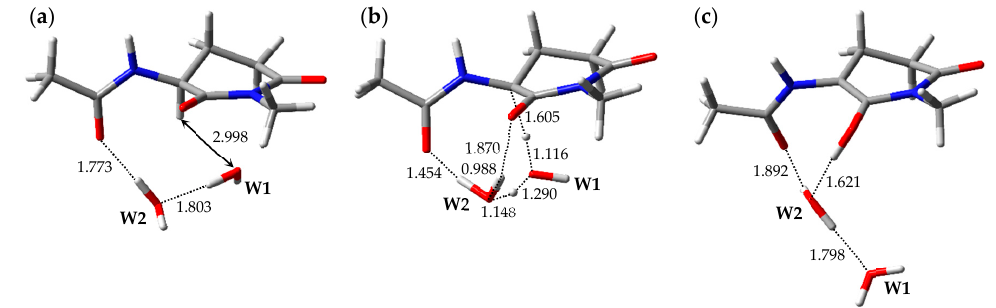
Figure 3. Optimized geometries of the enolization system in Pathway 2: ( a ) 2-RC ( φ = − 101°, ψ = − 158°, χ 1 = − 180°, χ 2 = − 53°); ( b ) 2-TS ( φ = − 87°, ψ = − 152°, χ 1 = 176°, χ 2 = − 48°); and ( c ) 2-PC ( φ = − 100°, ψ = − 171°, χ 1 = − 158°, χ 2 = − 46°). The selected interatomic distances are shown in Å.